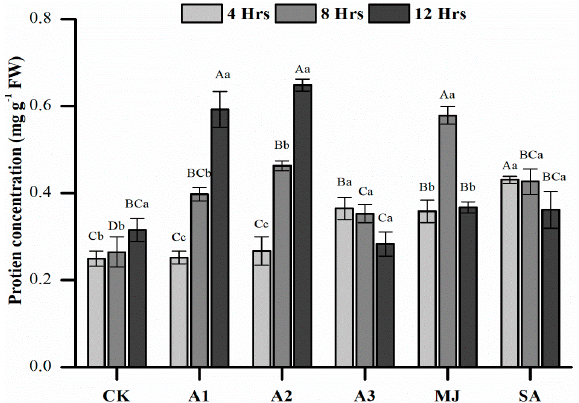
Figure 6. Total soluble protein concentration in eggplant seedlings after germination. Ck (distilled water), A1, A2, A3 (AGE 100, 200, 300 µg mL − 1 ), MJ (MeJA 0.05 mM), SA (Salicylic acid 0.5 mM), whereas 4, 8-, and 12-h are priming durations. Bars represent mean and standard errors ( n = 4). Data